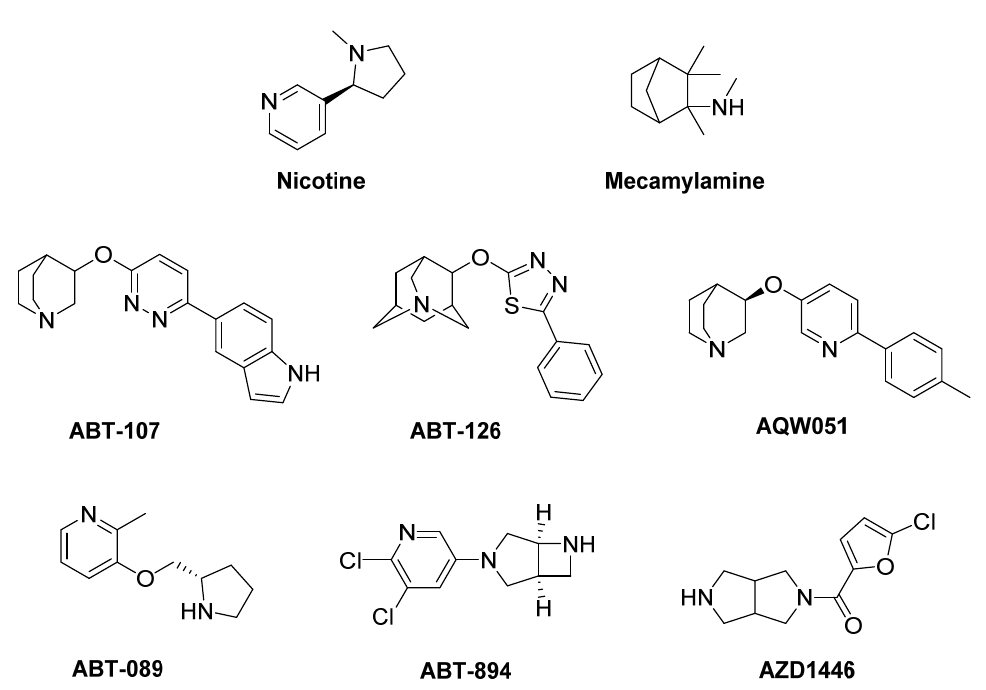
Figure 14. Nicotinic receptor ligands.